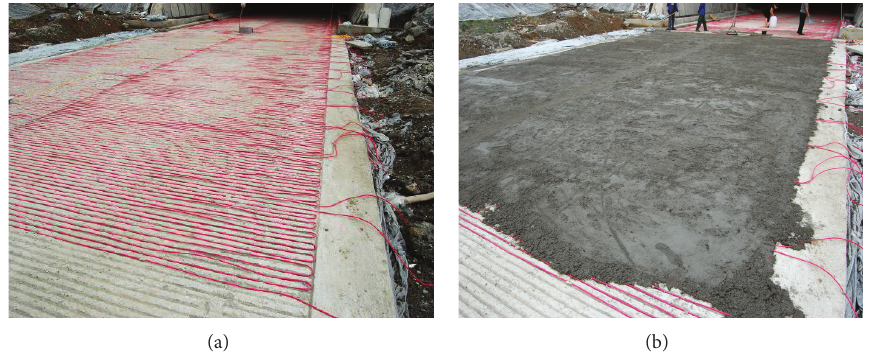
Figure 8: On-site construction of electric heat tracing system.